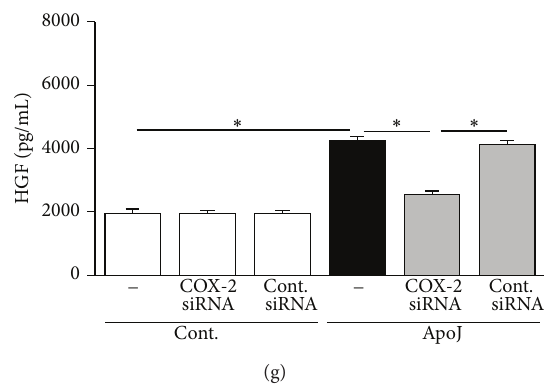
Figure 5: Apoptotic cell-induced HGF production in murine peritoneal macrophages is dependent on COX-2/PGE 2 signaling. (a, b) Murine peritoneal macrophages were stimulated with apoptotic (ApoJ) or viable (ViaJ) Jurkat cells for the times indicated. After 1 h of pretreatment of 10 𝜇 M NS-398 or 10 𝜇 M AH-6809 (AH), peritoneal macrophages were stimulated with ApoJ for 2 h to detect HGF mRNA (c) or for 24 h to detect HGF protein (d, e). (f, g) Peritoneal macrophages were transfected with COX-2 siRNA or control vehicle (siRNA-GFP) for 6 h and then stimulated with ApoJ for 24 h. (a, c) COX-2, COX-1, or HGF mRNA levels were analyzed using semiquantitative RT-PCR and normalized to 𝛽 -actin mRNA levels. (b, e, f) Immunoblots of total cell lysates were performed with anti-COX-2, COX-1, or HGF 𝛼 antibodies. (d, g) HGF levels in conditioned media were measured by ELISA. Values represent mean ± SEM of three or more separate experiments; ∗ 𝑃 < 0.05